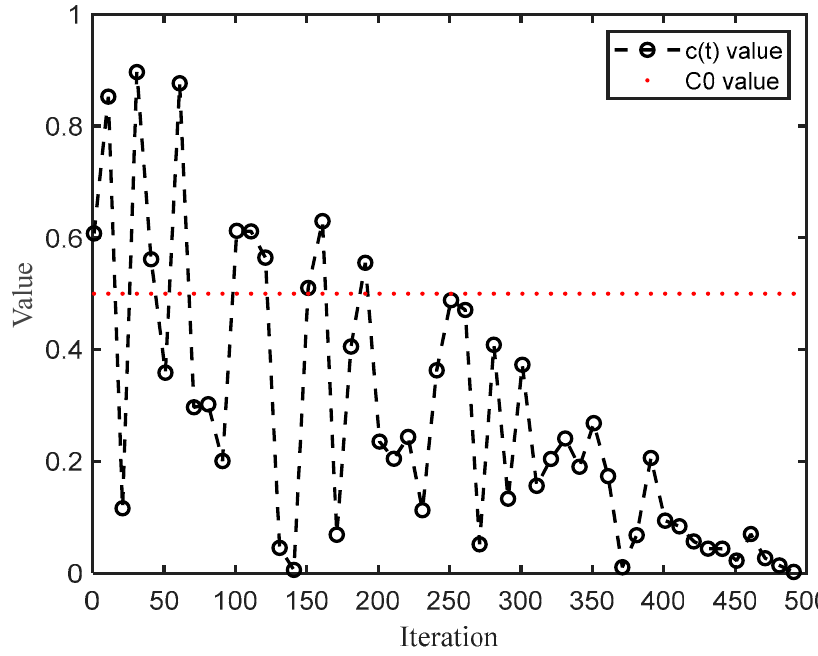
Figure 1. Time control function [23].